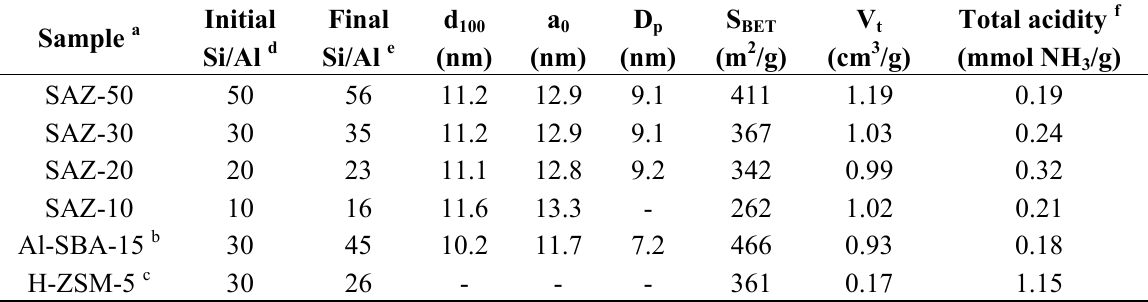
Table 1. Physicochemical properties of SAZ materials, Al-SBA-15 and